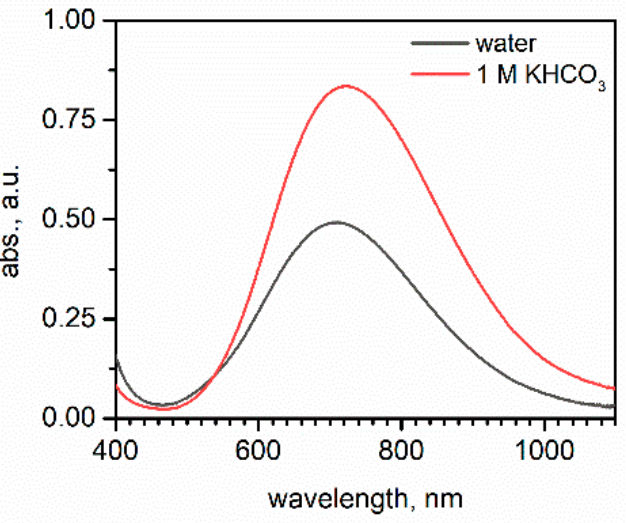
Figure 4. Electronic spectra of copper lactate complexes (16 mM) in water (pH = 8.5) and 1 M KHCO 3 solution (pH = 8.16).